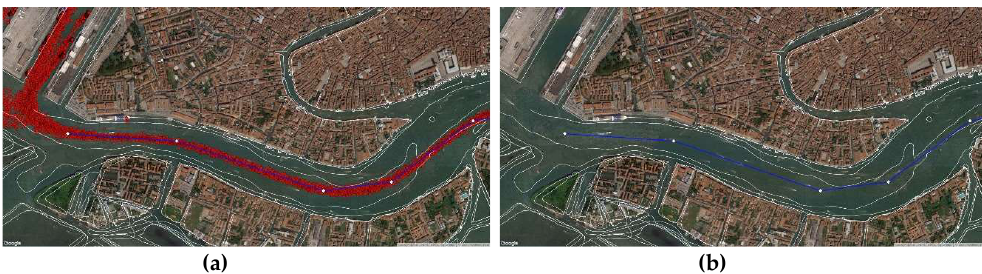
Figure 11. ( a ) Statistical followed route in the area of Venice; ( b ) Resulting Virtual AtoN.